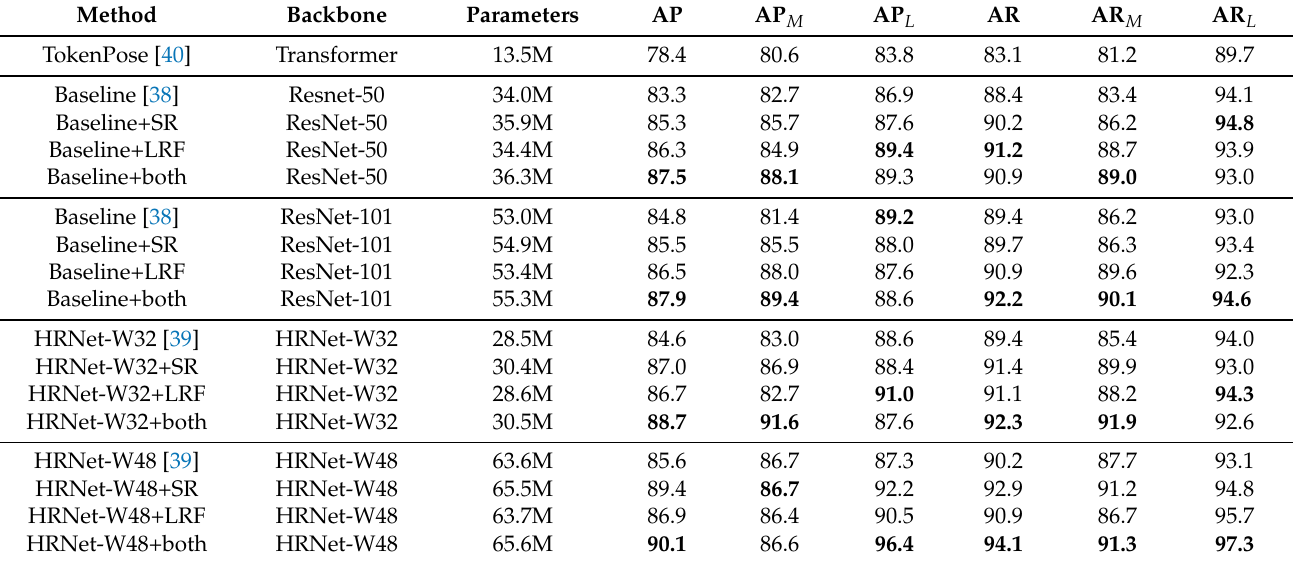
Table 1. Comparison with state-of-the-art baseline